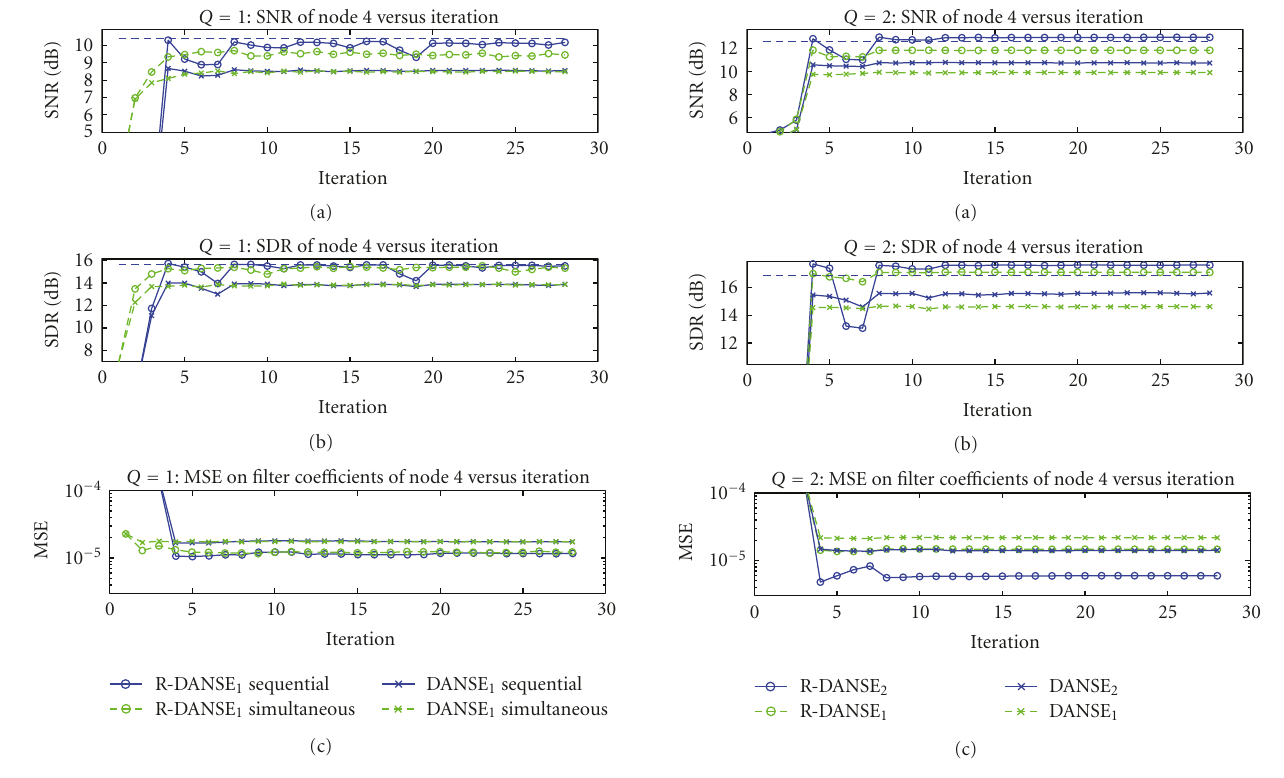
Figure 7: Scenario 2: SNR, SDR and MSE on filter coe ffi cients versus iterations for DANSE 1 , R-DANSE 1 , DANSE 2 and R-DANSE 2 at node 4. Speakers B and C are target